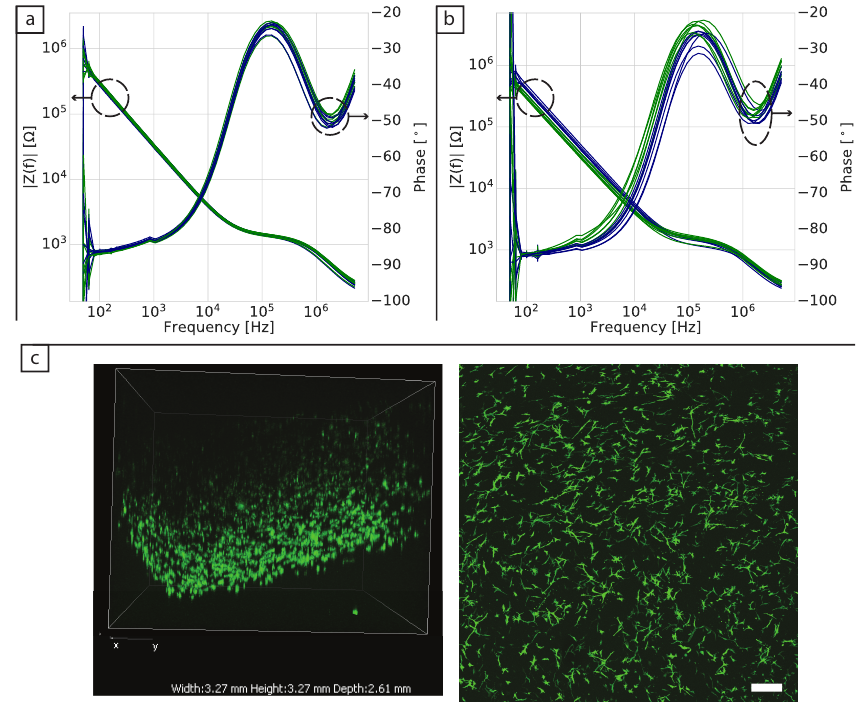
Figure 4. Impedance spectra of BJ-5Ta cells ( a ) 24 h and ( b ) eight days after seeding in 3D. Dark blue lines are from control wells containing collagen with DMEM + FBS medium, while dark green lines are from wells containing cells in collagen and cell medium. ( c ) Confocal pictures of collagen seeded with 3 × 10 4 cells fixed after 24 h of culture and stained with phalloidin. ( left ) Side view of 3D confocal volume and ( right ) maximum intensity projection in the XY plane. Scale bar represents 250 µ m.